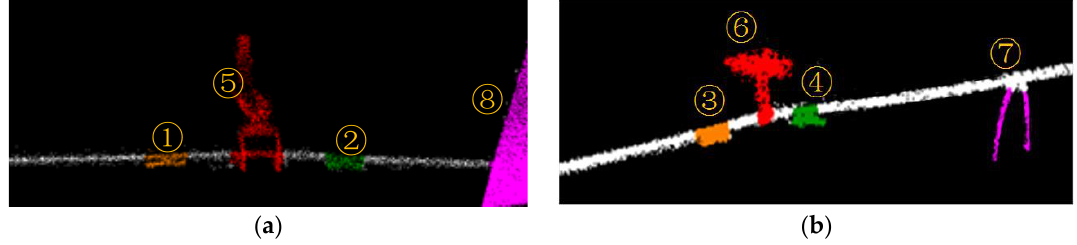
Figure 18. Classification results: ( a ) classification point clouds of Line 1; ( b ) classification point clouds of Line 2.